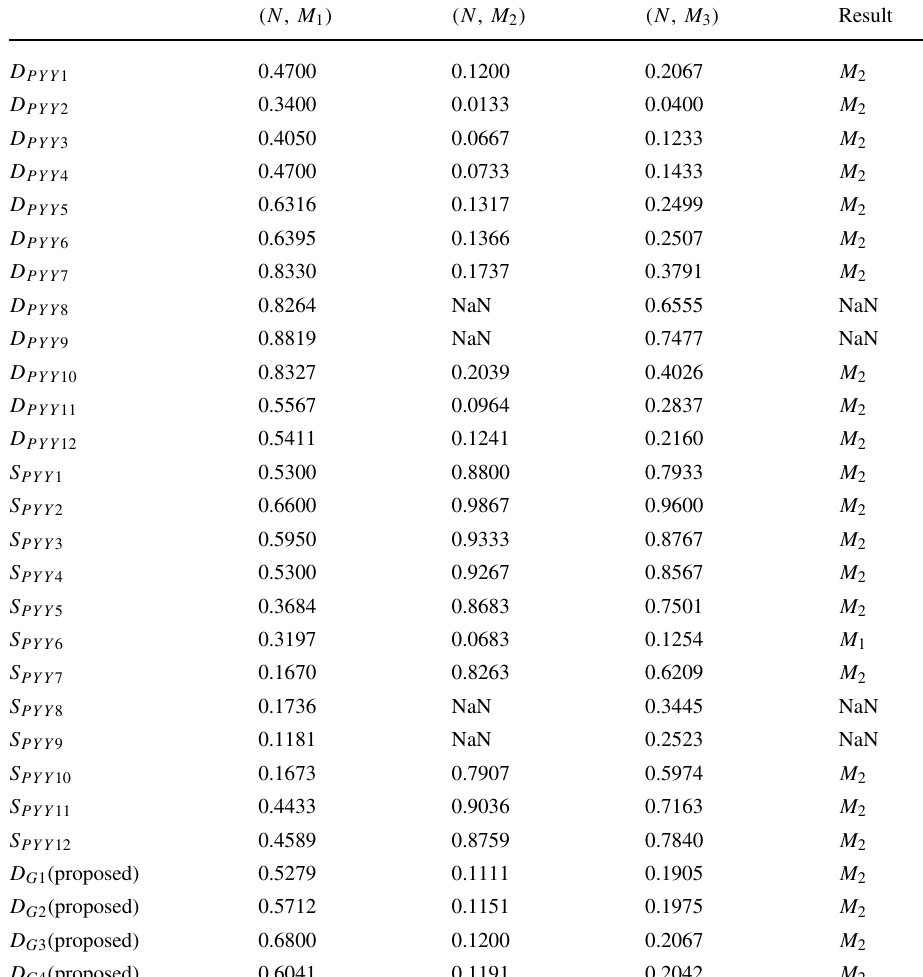
Table 8 Computed values of distance/similarity between the unknown pattern and known patterns regarding Example